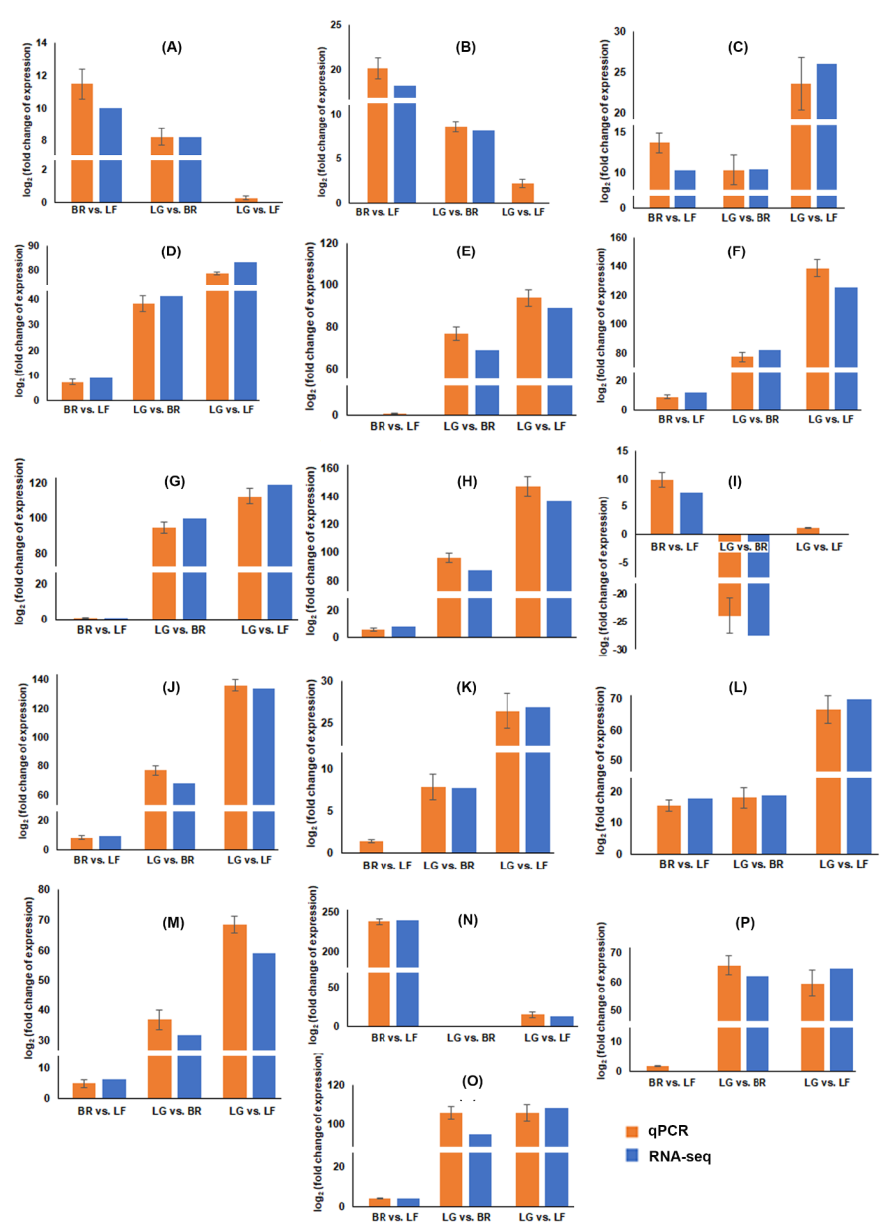
Figure 8. Validation of expression patterns of differentially expressed genes by RT-qPCR. Graph showing fold change of the structural genes, regulatory genes and two randomly selected genes in the pairwise comparison sets of the three stages, namely, bract compared to leaf (BR vs. LF), lupulin glands compared to bract (LG vs. BR) and lupulin glands compared to leaf (LG vs. LF). ( A ) PAL: phenylalanine ammonia lyase; ( B ) 4CL: coumarate coenzyme A ligase; ( C ) C4H: cinnamate 4-